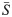
Activity scores as a function of region.Researchers from 115 countries answered the survey and we grouped them into regions based on t-tests comparing the mean score (S¯) of the country and region. The Latin region includes South American countries, Portugal, Spain, Italy, France, Greece, and Cyprus. Anglophones include the United States and many Commonwealth countries. Slavic nations comprise Eastern Europe and former Soviet states. India, Pakistan, Indonesia, Singapore, and Bangladesh are part of the South Asia region. The Germanic states include European countries north of France/Italy. Middle East and Africa (MEA) is the most diverse grouping and includes Iran, Turkey, Arabic-speaking nations and sub-Saharan Africa (some of which could have been included among the Commonwealth nations). China, Japan, South Korea, Taiwan, Vietnam comprise the Far East Asia region (FEA).